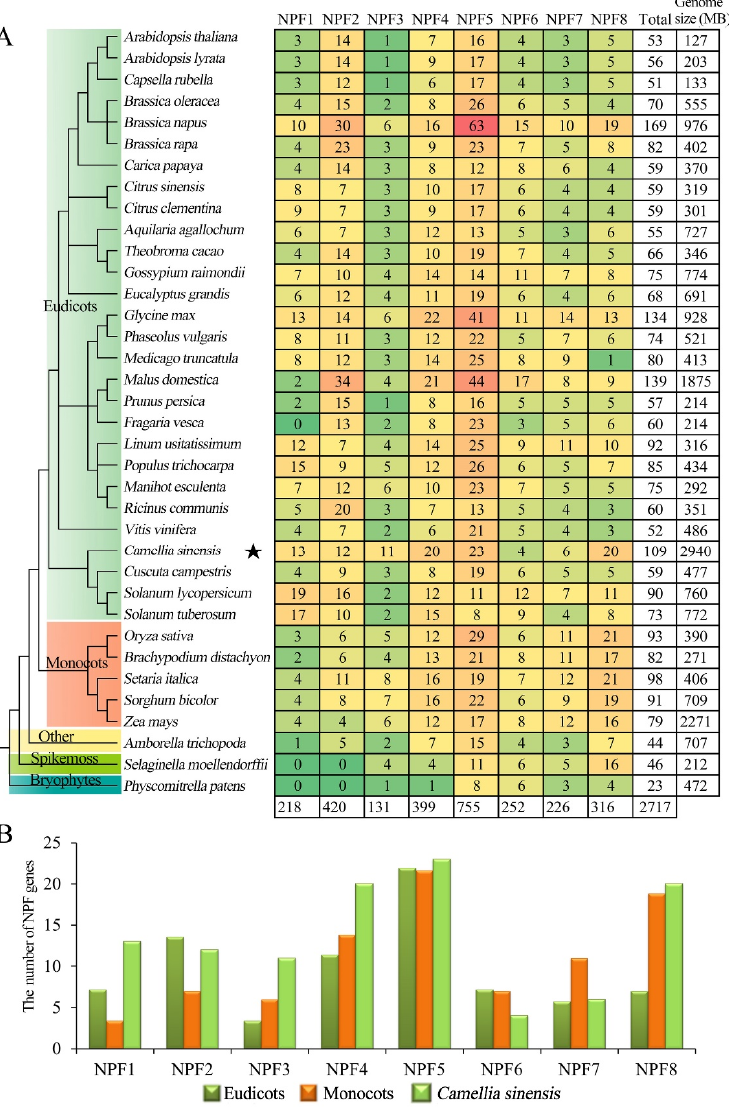
Figure 3. Comparison of NPF genes in different species. ( A ) Classification of NPF genes from 36 plant species. ( B ) Distribution of NPF genes in tea plant compared with the average number in eudicots and monocots. The phylogenetic tree of the 36 plant species was downloaded from the NCBI website (https://www.ncbi.nlm.nih.gov/Taxonomy/CommonTree/wwwcmt.cgi (accessed on 15 October 2021)) and reconstructed by MEGA5.